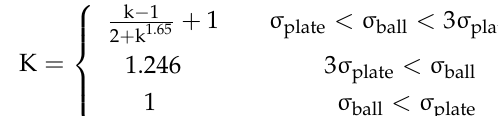
Figure 6. Influence of different yield strength ratios on the coefficient of restitution.